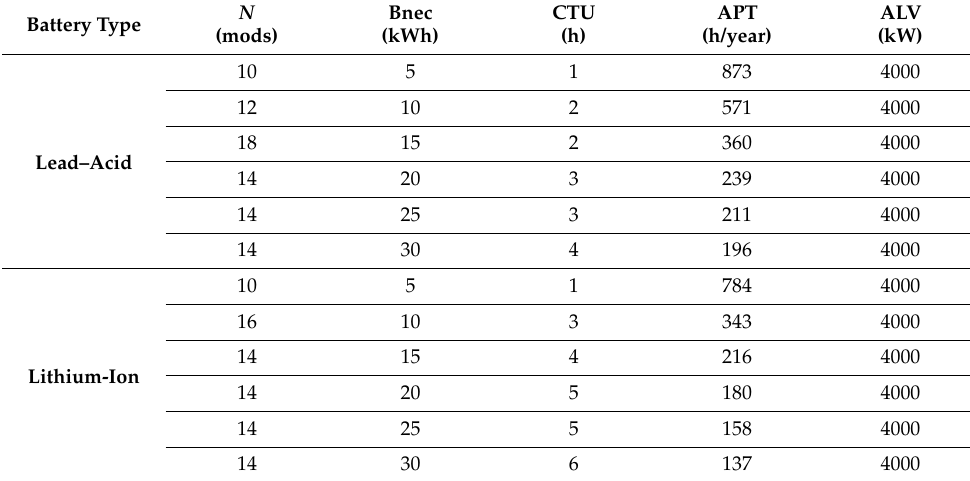
Table 3. The maximum continuous time use (CTU), the estimated annual operation time (APT), and the average load value (ALV) of the standby diesel genrator in diverse simulation